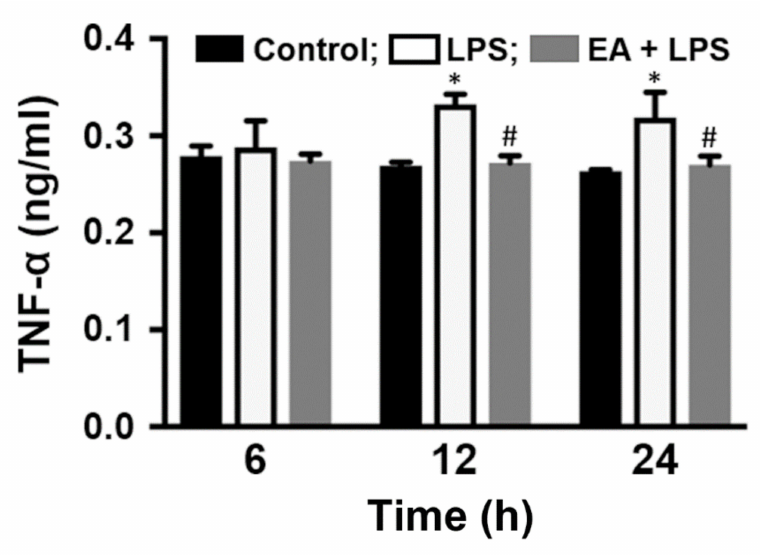
Figure 4. EA inhibits TNF- α production in CTX TNA2 cells. CTX TNA2 cells were treated with EA (10 µ M) for 15 min and then stimulated with LPS (250 ng/mL) for 6, 12 or 24 h. The protein levels of TNF- α in the culture medium were analyzed by ELISA ( n = 3). * p < 0.05 compared to the untreated group, # p < 0.05 compared to the LPS